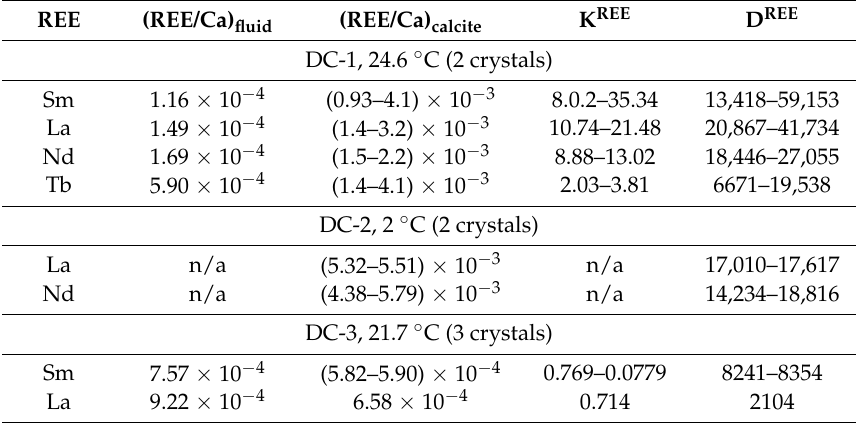
Table 2. The lower limits of the partition coefficients between REE and